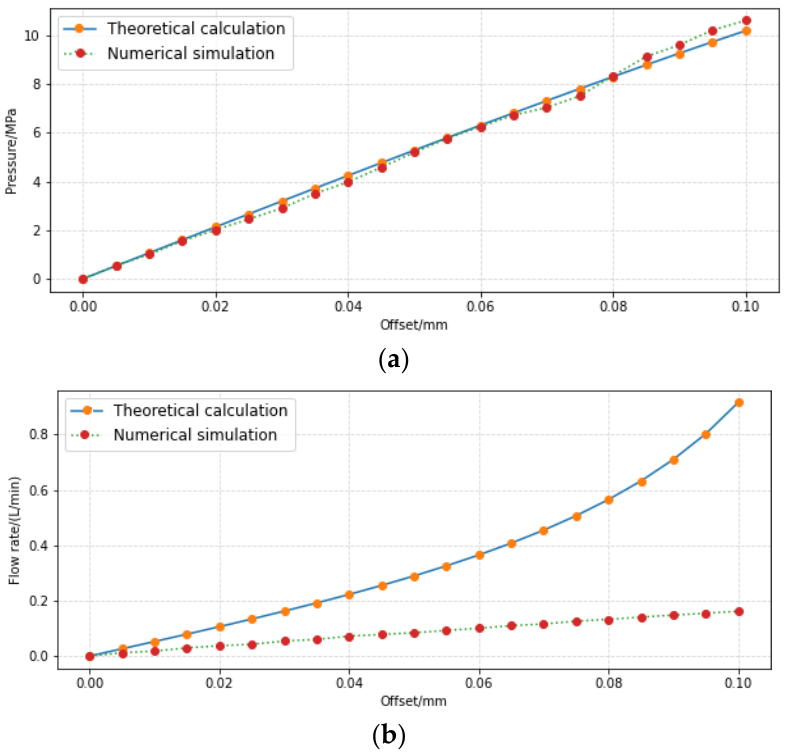
Figure 14. Calculation results versus simulations: ( a ) curves of pressure with offset; and ( b ) curves of flow with offset.